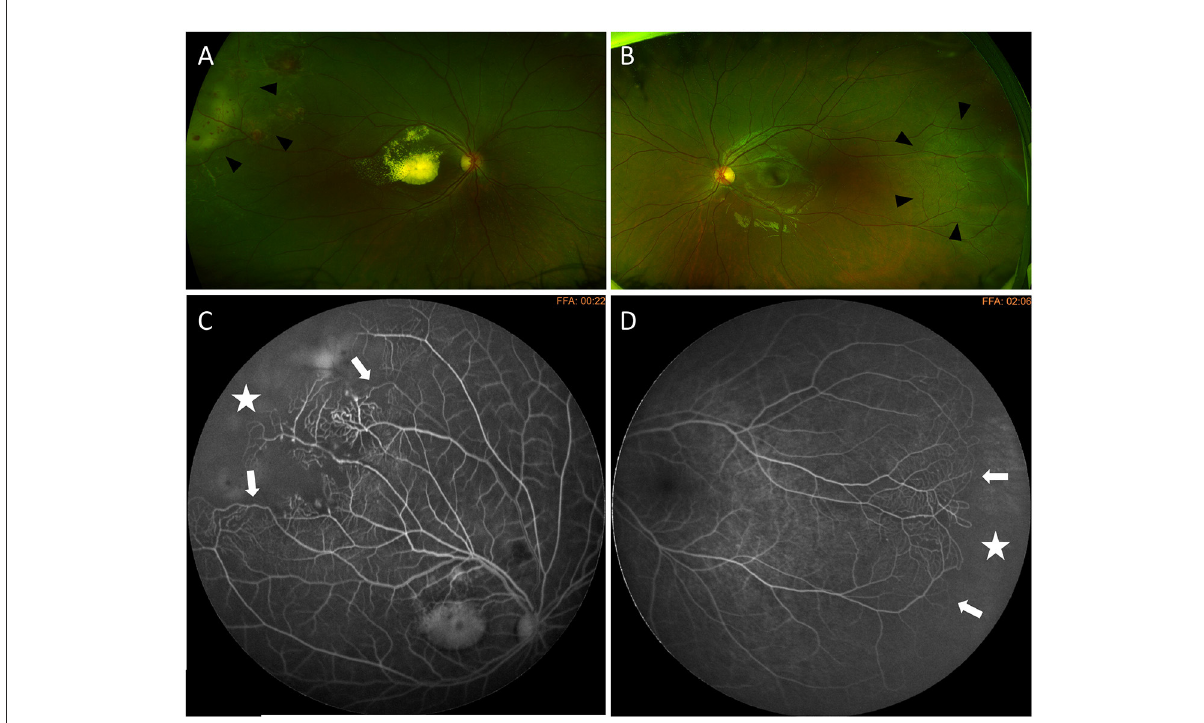
FIGURE3 Bilateral Coats’ disease in a 6-year-old girl. Optos wide-field fundus photography shows a stage 2B with macular exudation and peripheral telangiectasia (arrow heads) on the right eye (A) and telangiectasia located in the temporal periphery (arrow heads) on the left eye (B) . Fluorescein angiography shows capillary dilatation and dropout (white arrows) and a peripheral avascular area (white star) on both eyes (C) right eye (D) left